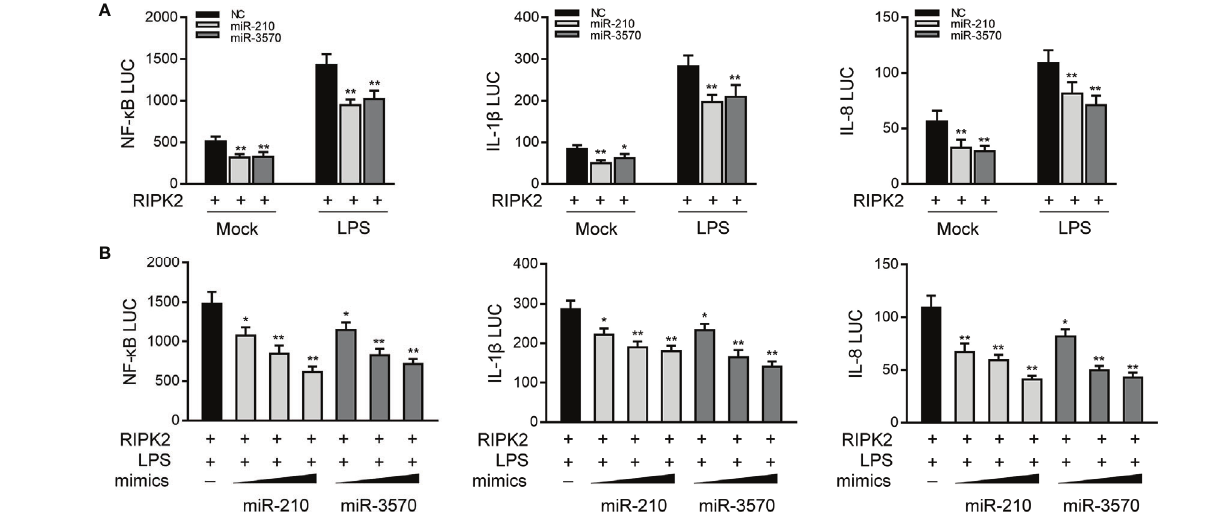
FIGURE 5 | miR-210 and miR-3570 inhibit RIPK2-induced NF- k B signaling. (A) NC, miR-210, miR-3570 together with the pRL-TK renilla luciferase plasmid, NF- k B, IL-1 b or IL-8 luciferase reporter gene and the RIPK2 expression plasmid were cotransfected with EPC cells for 24 h. Then the cells were stimulated with LPS for another 6 h and the luciferase activity was assessed. (B) miR-210 (0, 50, 100 nM) or miR-3570 (0, 50, 100 nM) in a concentration-gradient manner, together with luciferase reporter gene NF- k B, IL-1 b and IL-8 were transfected with EPC cells for 24 h, the EPC cells were treated with LPS for 6 h, after which the luciferase activity value was determined by using the Dual-Luciferase reporter assay system. Luciferase activity was normalized to renilla luciferase activity. All data are presented as the means ± SE from three independent triplicate experiments. **p < 0.01; *p < 0.05 versus the